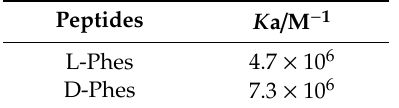
Table 1. The binding constants Ka of peptides to 1,2-dimyristoyl- sn -glycero-3-phosphocholine (DMPC) using quartz crystal microbalance